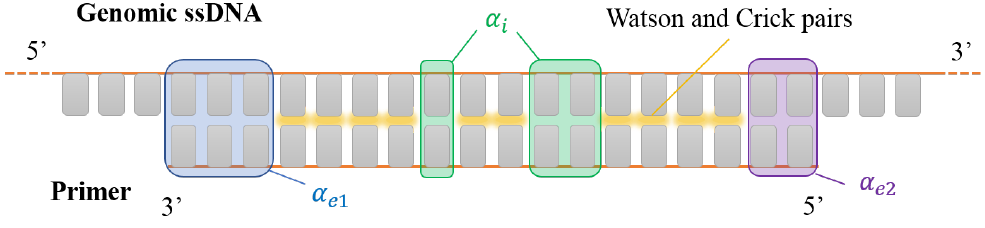
Figure 1. Sketch of a DNA primer interacting with a generic portion of a DNA single strand of a denaturated genome. Gray rectangles represent the nucleobases. Canonical Watson–Crick pairing is marked in yellow. Shaded boxes mark pairing defects: internal mismatches (green shades, counted by α i ), terminal mismatches at the 3 (cid:48) and 5 (cid:48) ends (blue shades, α e 1 and purple shades, α e 2 respectively). In this sketch, α i = 3, α e 1 = 3 and α e 2 = 2.